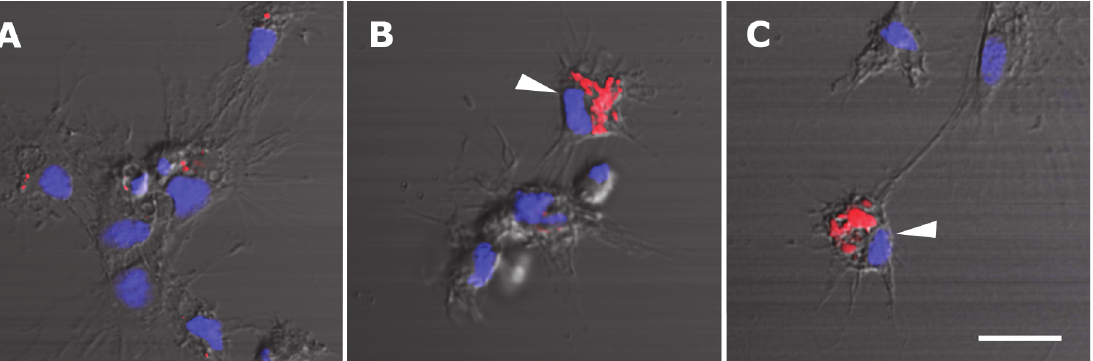
Fig 2. Circulating hemocytes (LysoTracker Red-Hoechst 33258). (A) A group of spreading hyalinocytes; small acidic granules (red) are seen in some of them. (B) A spreading granulocyte (arrowhead) showing numerous rod-shaped, acidic granules; also, there is a group of spreading and round hyalinocytes, which are essentially devoid of acidic granules. (C) Another spreading granulocyte (arrowhead) showing large and merging acidic granules; also, there are two spreading hyalinocytes with no acidic granules. Scale bar represents 10 μ